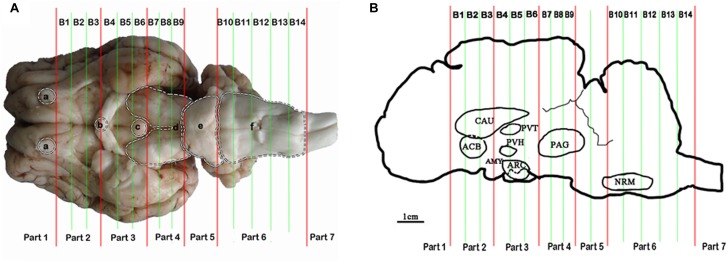
Brain sectioning. (A) (a) the residual part of the olfactory bulbs, (b) optic chiasm, (c) mamillary body, (d) cerebral peduncles, (e) pons, and (f) medulla oblongata. (B) In the blocks nuclei or areas: the nucleus accumbens (ACB) and the caudate nucleus (CAU) in B2, the paraventricular nucleus of the thalamus (PVT) and the paraventricular nucleus of the hypothalamus (PVH) in B4, the arcuate nucleus (ARC) and the amygdala (AMY) in B5, the periaqueductal gray (PAG) in B8 and the nucleus raphe magnus (NRM) in B13 are located.